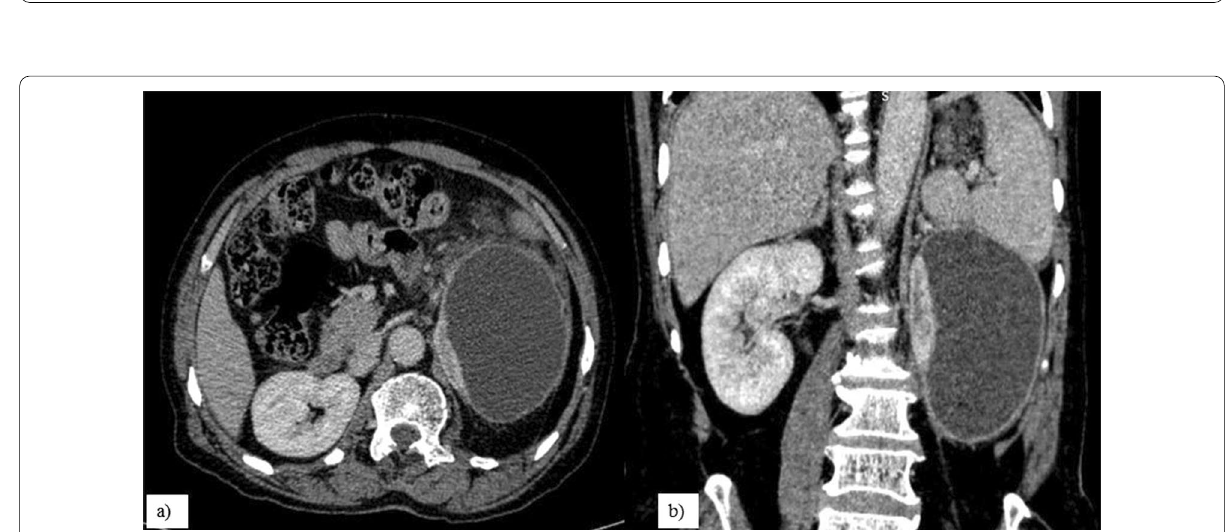
Fig. 3 CECT abdomen: a axial and b coronal images showing the perirenal pseudocyst causing compression and displacement of left kidney resulting in relatively reduced cortical opacification compared to opposite